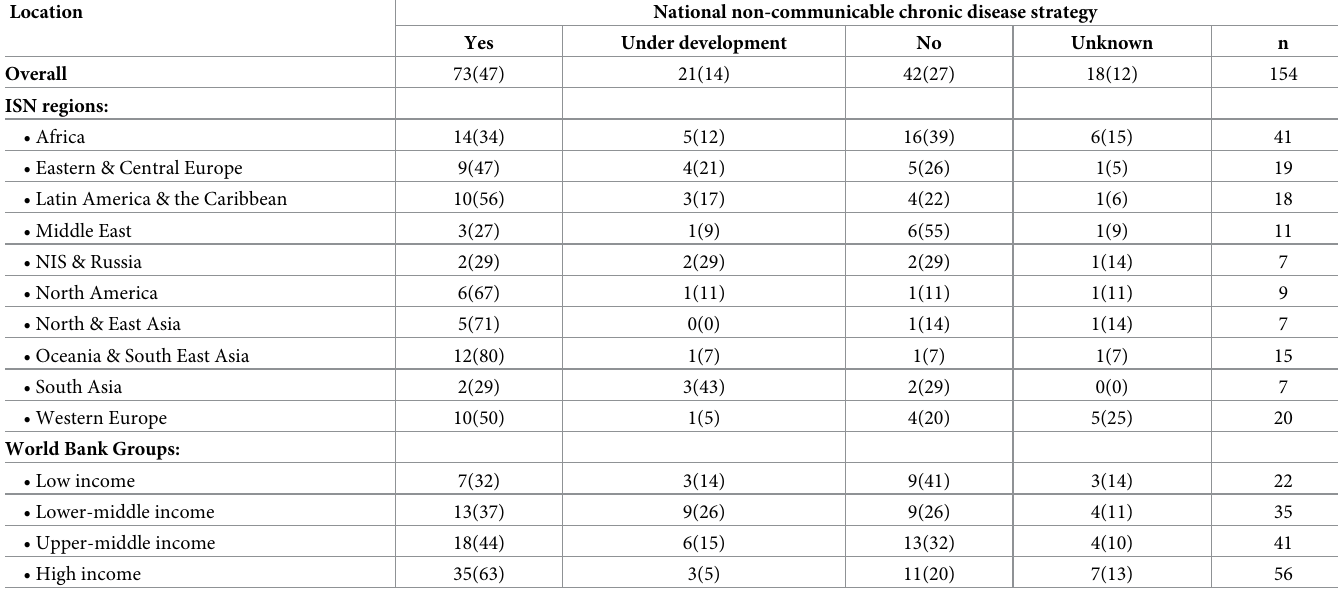
Table 1. Existence of a national strategy for NCDs. Numbers represent countries